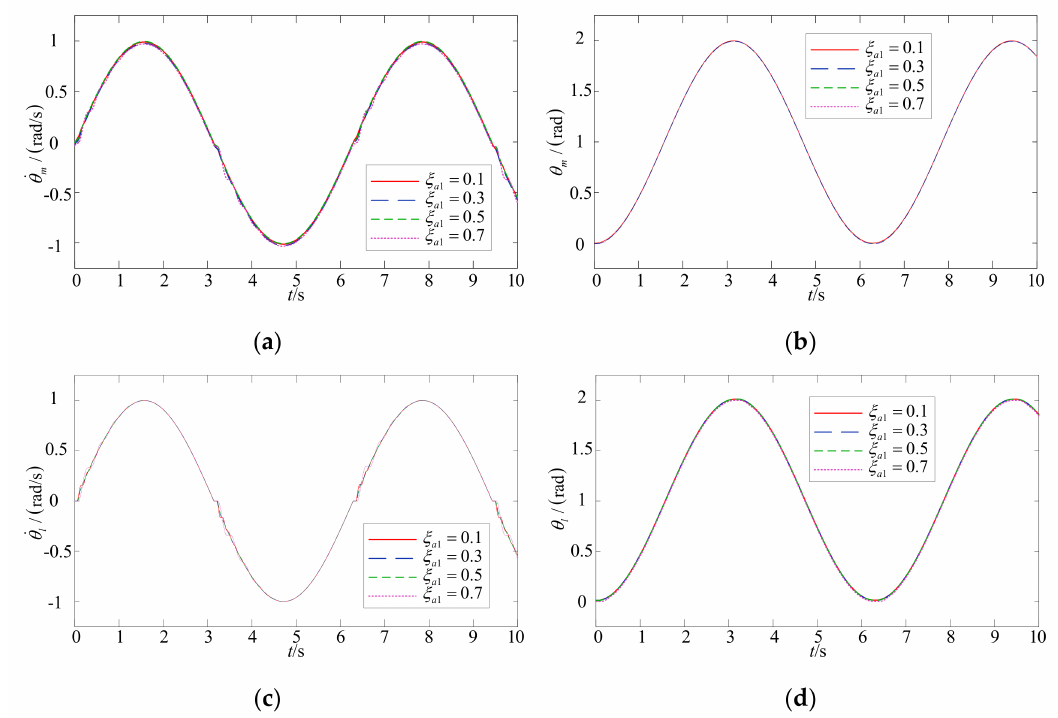
Figure 12. Simulation results under sinusoidal signal. ( a ) Motor end speed output ( b ) Motor end angle output. ( c ) Load end speed output ( d ) Load end angle output.